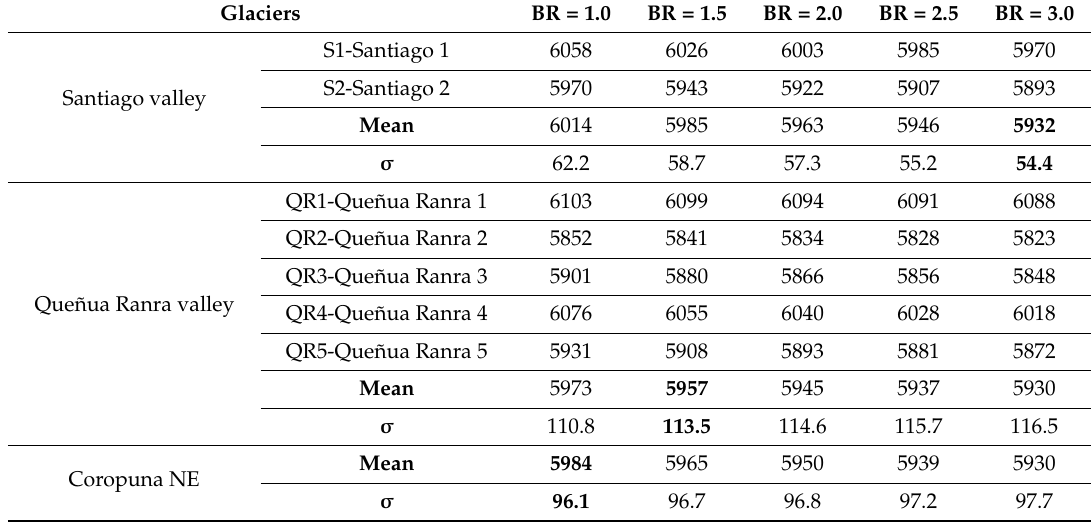
Table 2. ELAs AABR 2010 and Balance Ratio (BR)